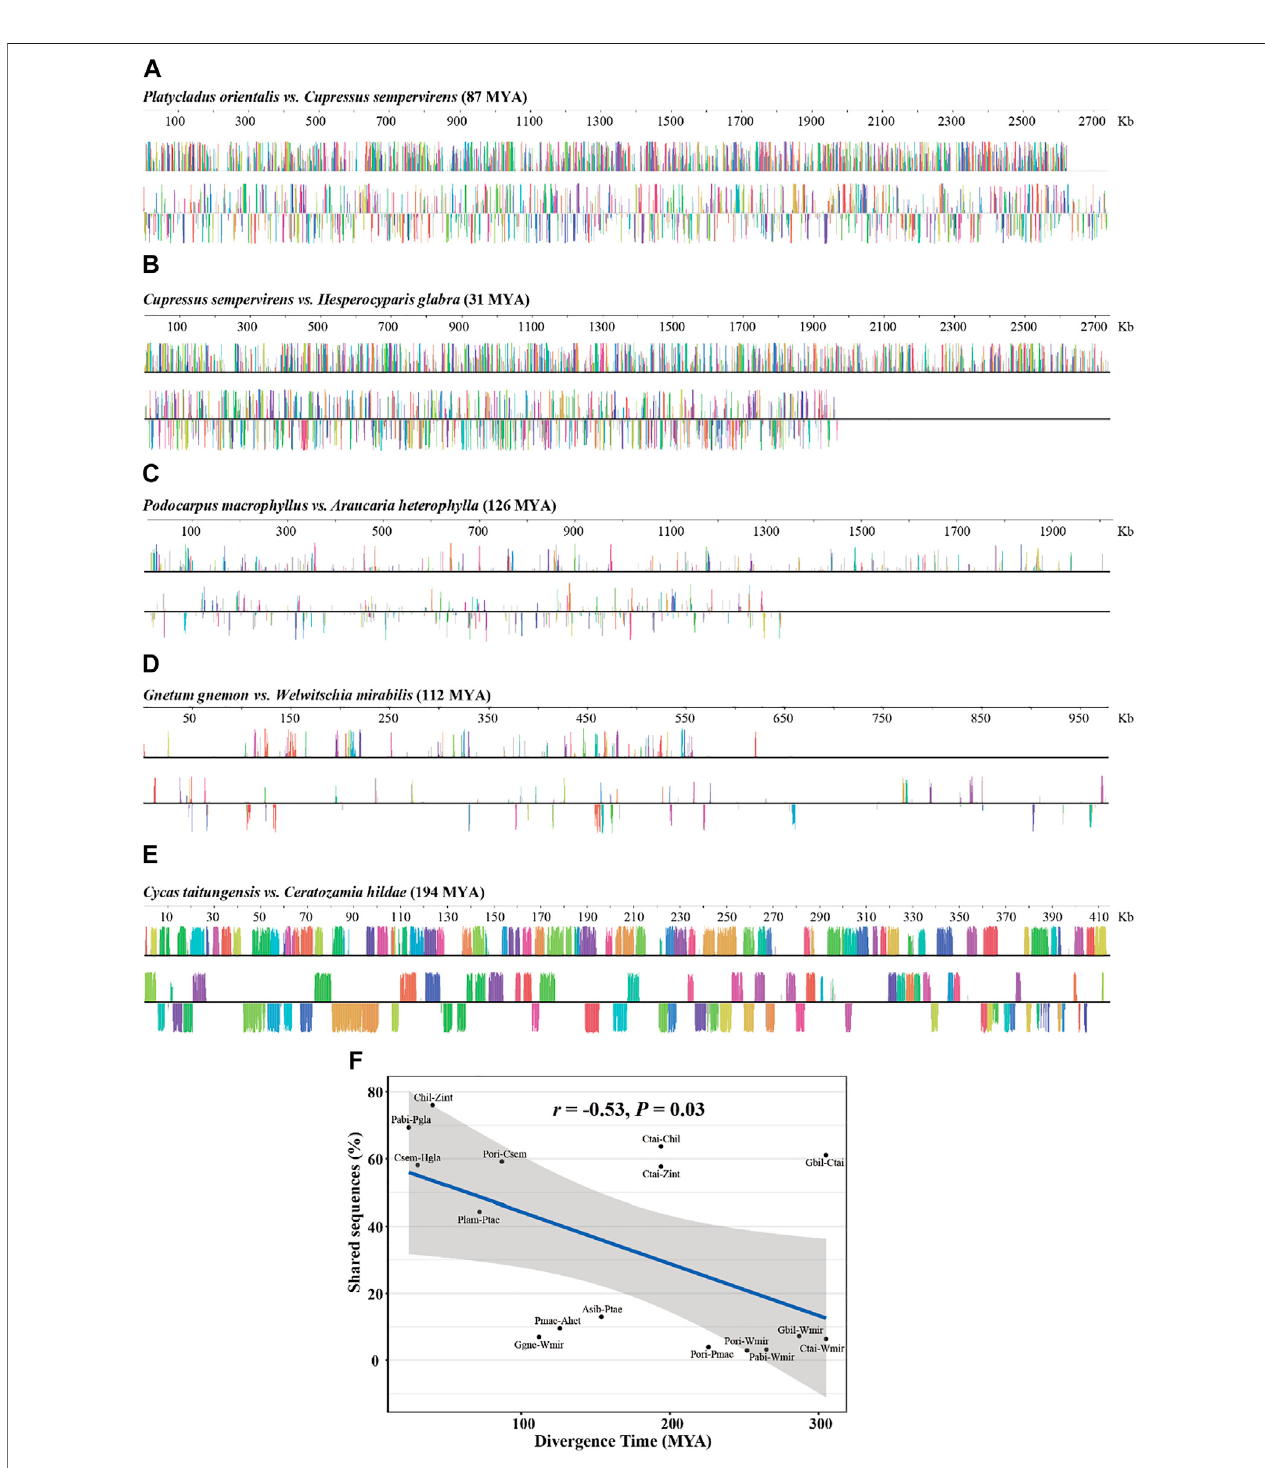
FIGURE 3 | Mitogenome alignments between gymnosperm species showing the locally collinear blocks at varying divergence time. (A) Platycladus orientalis vs. Cupressus sempervirens . (B) Cupressus sempervirens vs. Hesperocyparis glabra . (C) Podocarpus macrophyllus vs. Araucaria heterophylla . (D) Gnetum gnemon vs. Welwitschia mirabilis . (E) Cycas taitungensis vs. Ceratozamia hildae . The color bars represent corresponding local collinear blocks, heights are proportional to pairwise sequence identity, and blocks below the center line indicate regions that align in the reverse complement (inverse) orientation. MYA, million years ago. (F) Correlationbetweendivergencetimeandthedegreeofsharedsequences.Thebluelinerepresentstheregression fi ttingwithalinearmodel.Thegreyshadowisthe95% con fi dence interval of the linear regression.